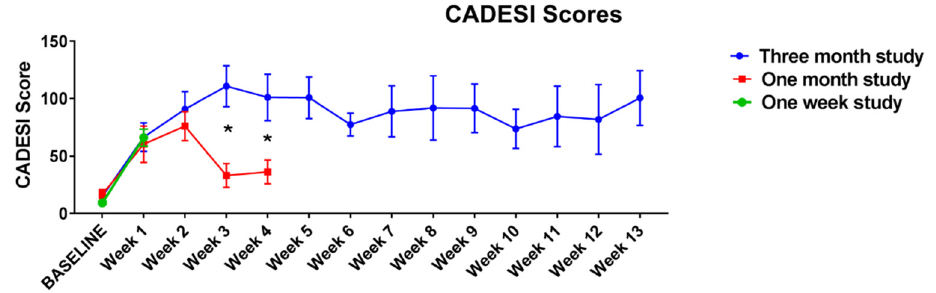
Figure 5. Clinical scores (Canine Atopic Dermatitis Extent and Severity Index [CADESI] means and standard deviations) of the first set of studies. When comparing the one-month study and the three- month study (week 0 − 4), a significant effect of the group was noted (two groups being different at weeks 3 and 4, p < 0.01, as indicated by the asterisk).